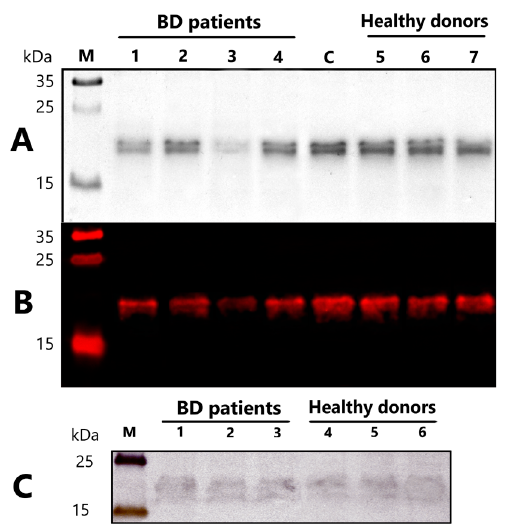
Figure 2. ( A ). SDS-PAGE analysis of the proteolytic activity of IgG in the hydrolysis myelin basic protein (MBP). ( B ). Immunostaining of reaction mixture after SDS-PAGE with primary anti-myelin basic protein antibody. The reaction mixtures containing 1 mg/mL MBP and 20 mM Tris-HCl (pH 7.5) were incubated for 20 h at 37 °C in the presence of 0.2 mg/mL IgG. Lanes 1–4—MBP after incubation with individual IgGs of patients with bipolar disorder (BD); lanes 5–7—MBP after incubation with individual IgGs of healthy donors; lane C—control reaction mixture without IgG; lane M—protein molecular weight markers. ( C ). Western blotting of MBP-binding IgG with primary anti-human IgG antibody. Lines 1, 2, 3–PVDF membrane with MBP after incubation in an equimolar mixture of three IgG from bipolar patients; lines 4, 5, 6—PVDF membrane with MBP after incubation in an equimolar mixture of three IgG from healthy donors; M—protein molecular weight markers.